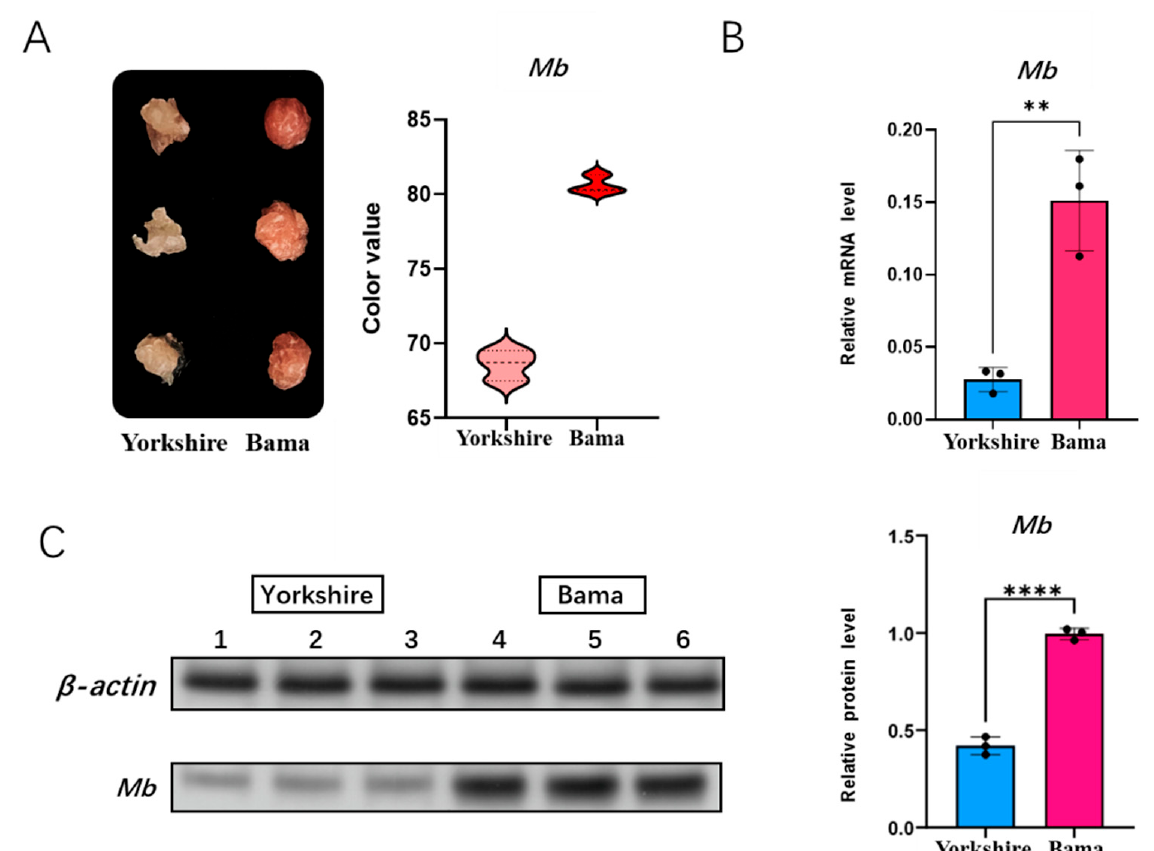
Figure 4. Detection of meat color and Mb gene expression. ( A ) meat color detection of Yorkshire and Bama as measured by the Germany Matthaus meat color tester Opto-Star; ( B ) Mb mRNA expression of Yorkshire and Bama as measured by RT-qPCR; ( C ) Mb protein expression of Yorkshire and Bama as measured by Western blot (Original Western Blot Figures are in Figure S1). ** p < 0.05, **** p < 0.01.